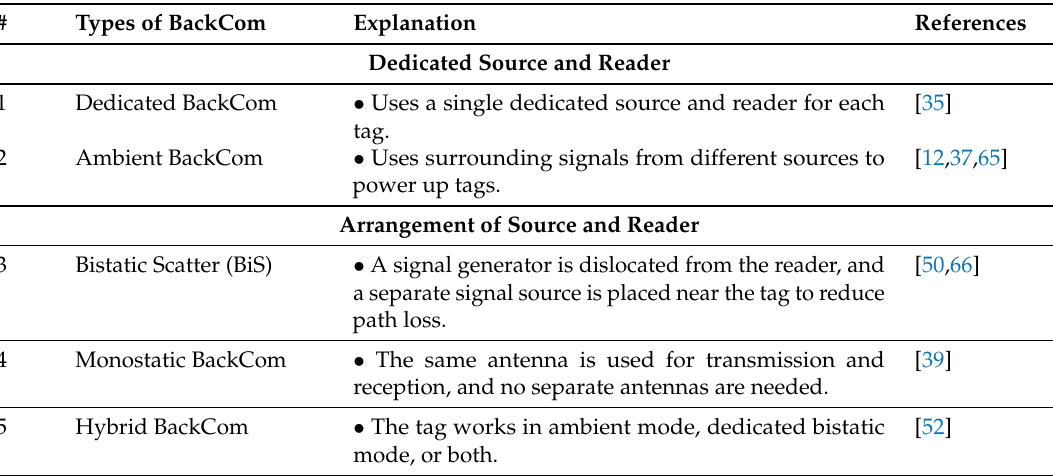
Table 3. Summary for Types of